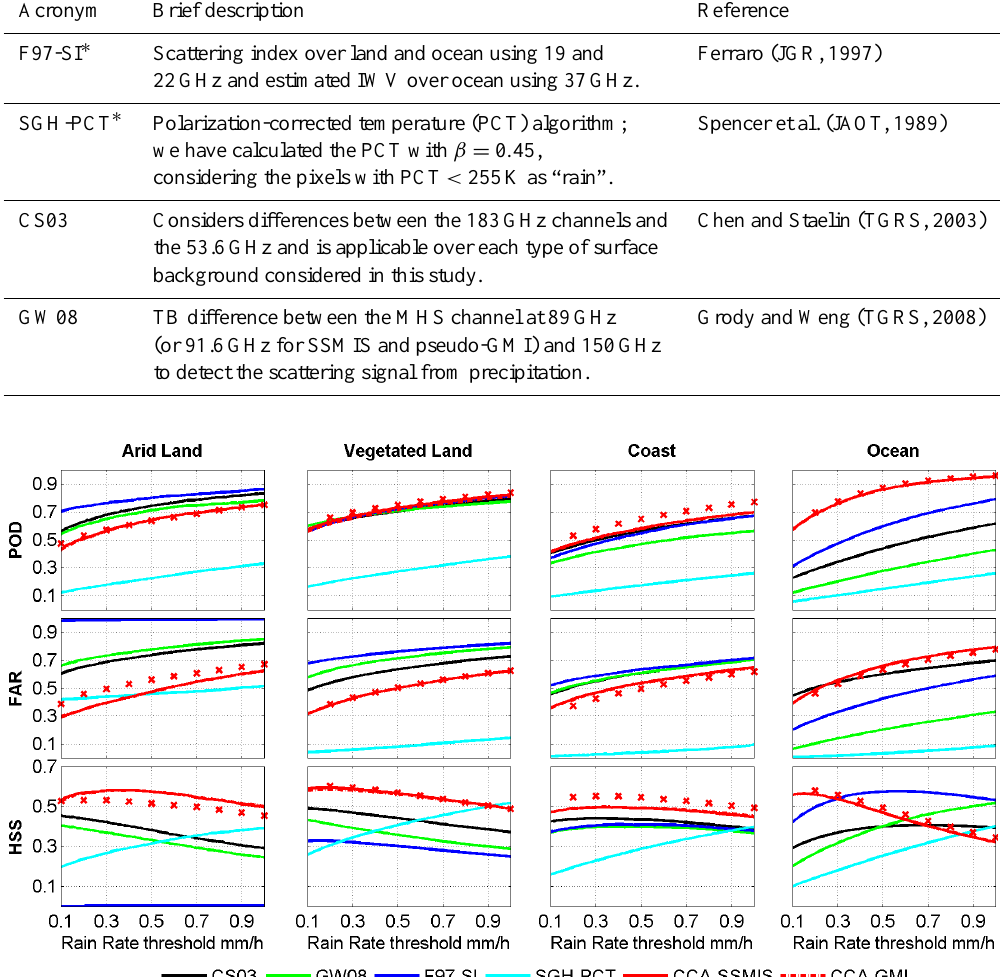
Figure 3. Comparison of the CCA-SSMIS and CCA-GMI algorithms with other similar algorithms for the detection of precipitation using the PR rain rate with a variable threshold (represented in the x axis) as ground truth for the precipitating pixels. The results are shown in four columns of panels (one for each surface type) in terms of POD (upper row of panels), FAR (middle row), and HSS (lower row). The scales are the same for every plot. Solid lines show the statistical indexes resulting from the application of a screening algorithm to the test data set (year 2013); red crosses are the result of the application of the SSMIS-CCA algorithm to the training data set (years